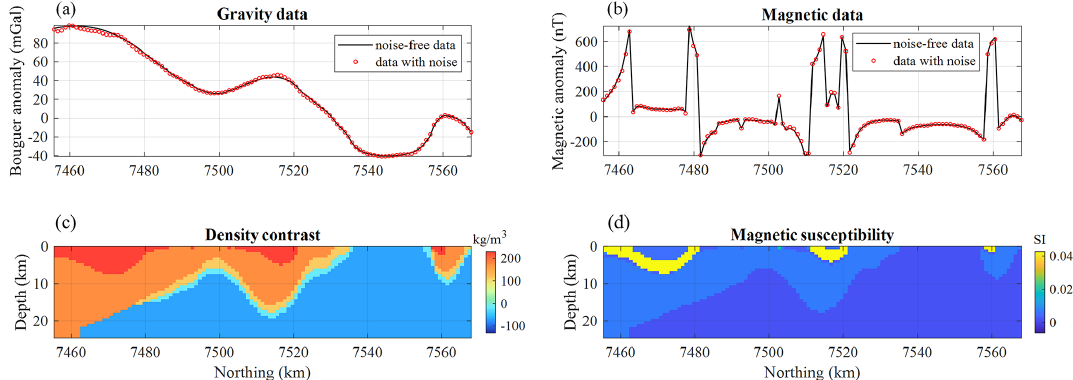
Figure 8. Two-dimensional slice extracted from the 3D model: gravity data and density contrast (a) and magnetic data and magnetic suscep- tibility (b)